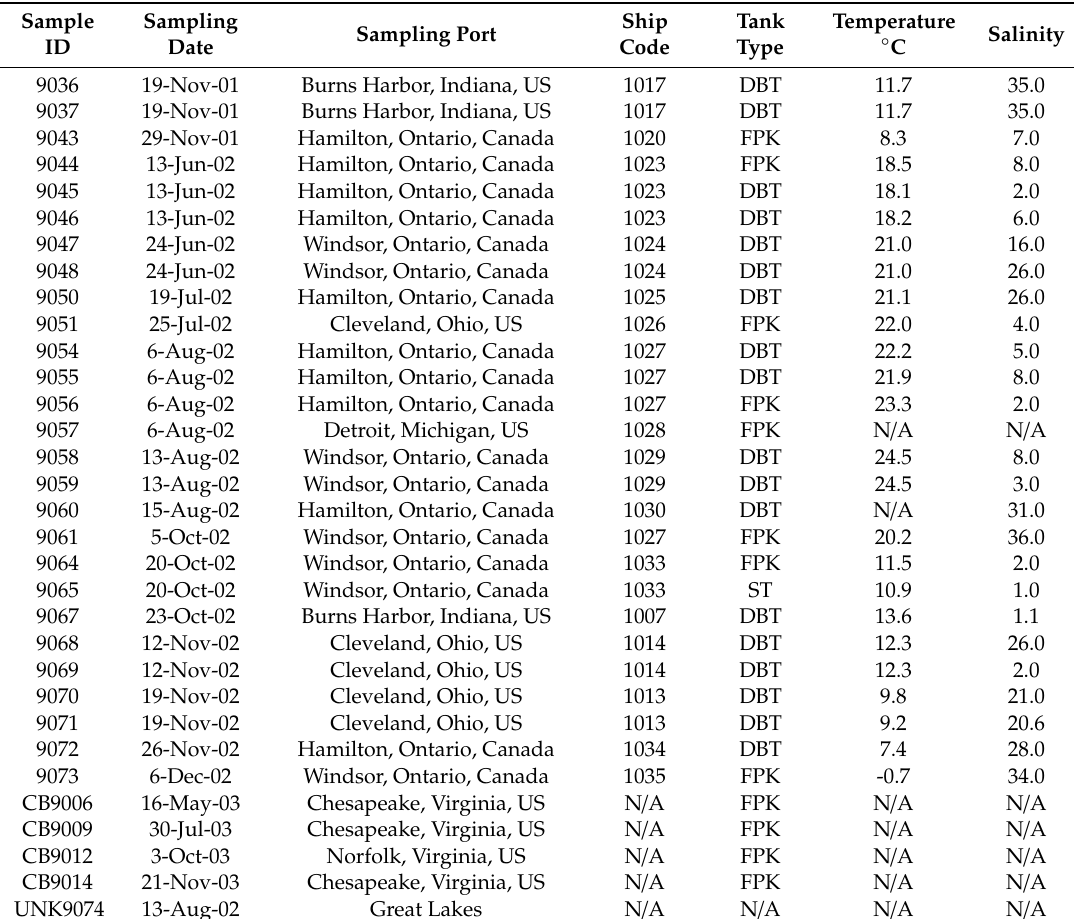
Table 1. Sediment samples collected from ballast tanks of ships entering the North American Great Lakes or Chesapeake Bay, USA, in 2001–2003. Identifying information includes collection dates and ports, ship IDs, tank types, and temperature and salinity of residual water in the tanks. Even when the same ship was sampled on a single date, each sample represents a unique tank. Modified from Appendix 2 of Johengen et al.